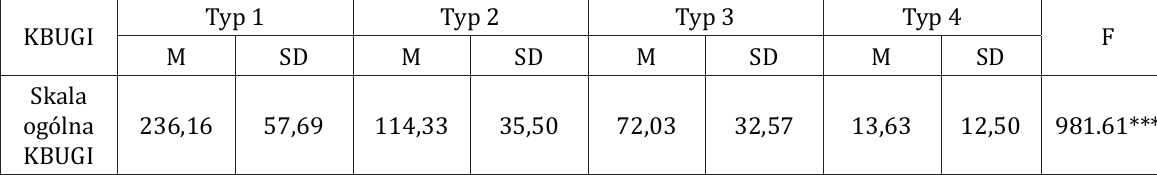
Tabela 3. Średnie wyniki 4 grup (typów) młodzieży uzyskane w skali ogólnej KBUGI